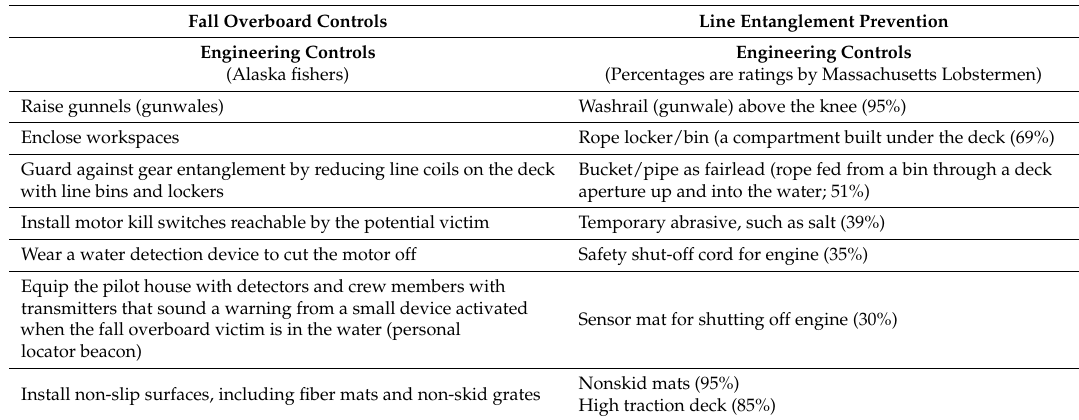
Table 2. Identified Controls for Fall Overboard Controls and Line Entanglement Prevention and